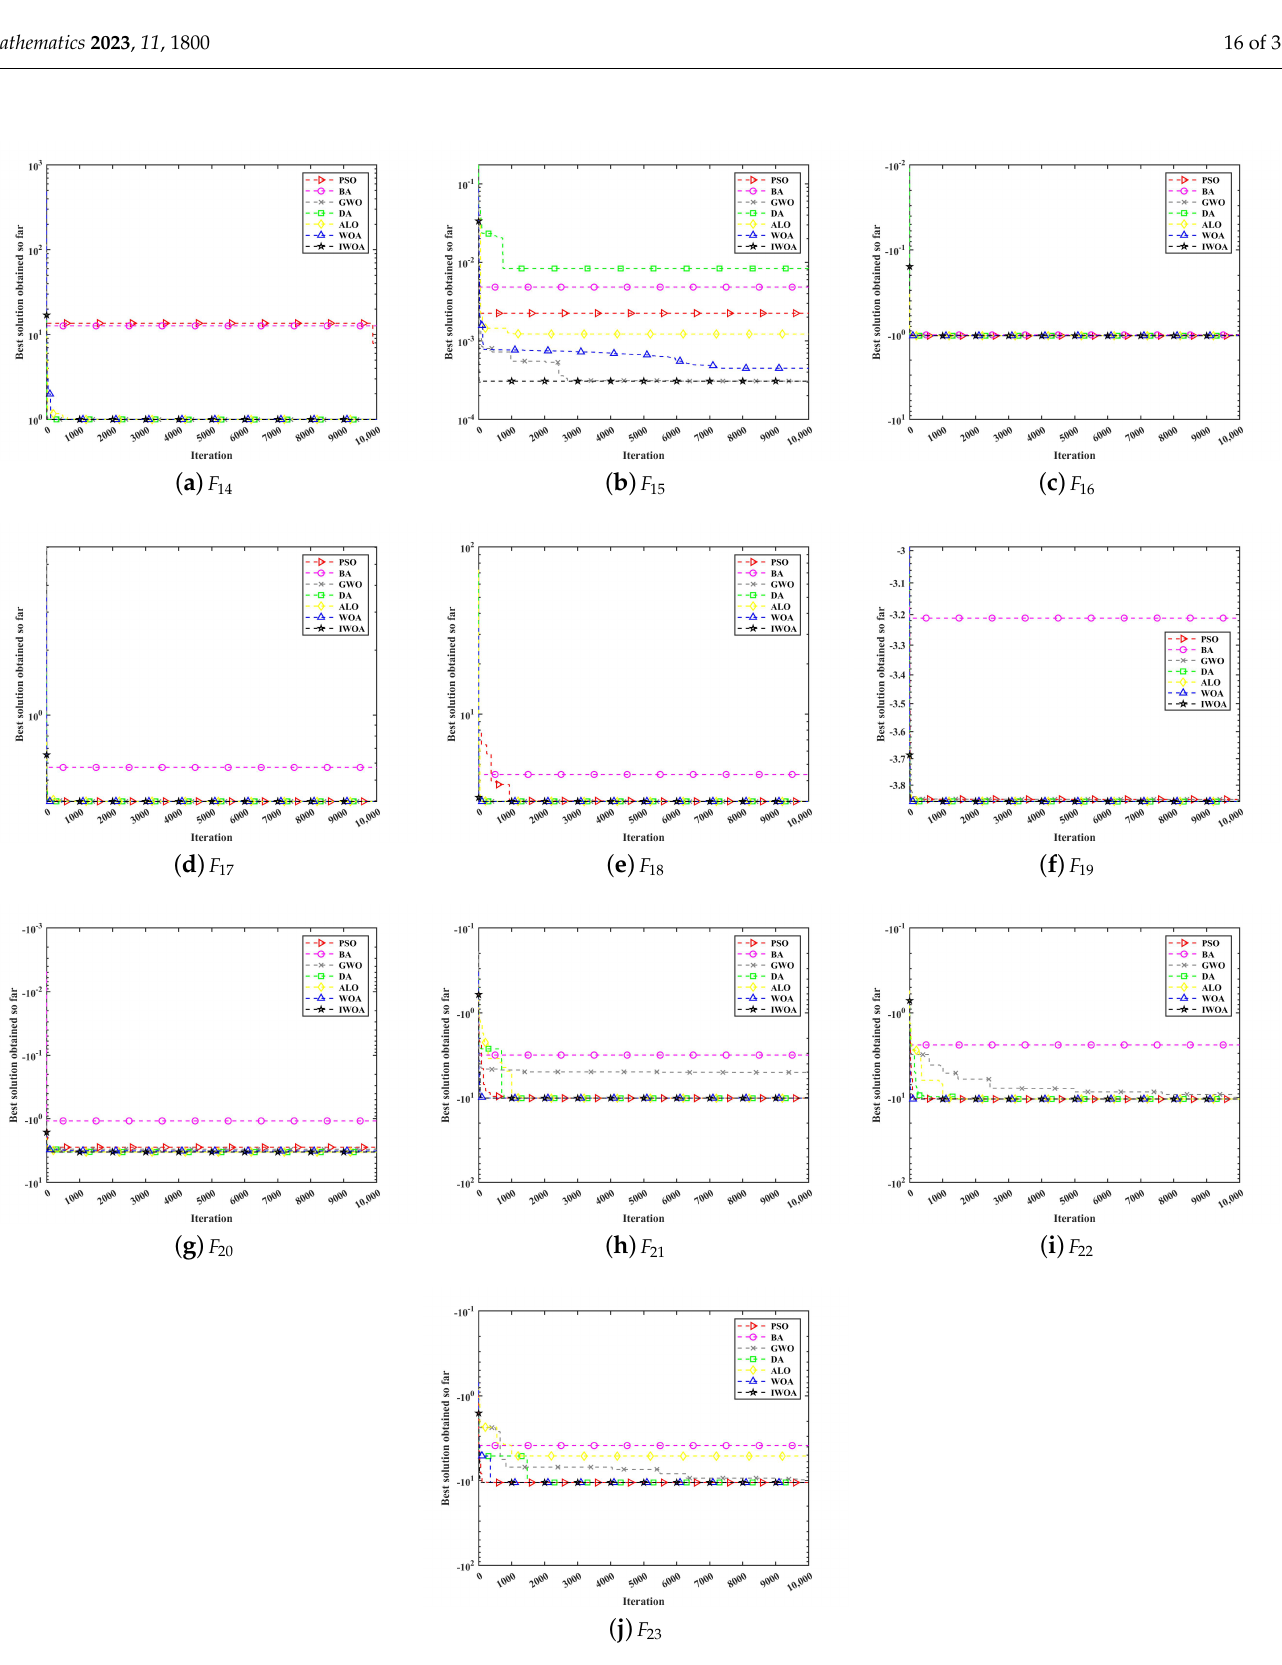
Figure 9. Different algorithms solve F 14 ∼ F 23 fixed dimension multi-modal test functions, and the solution value changes with the number of